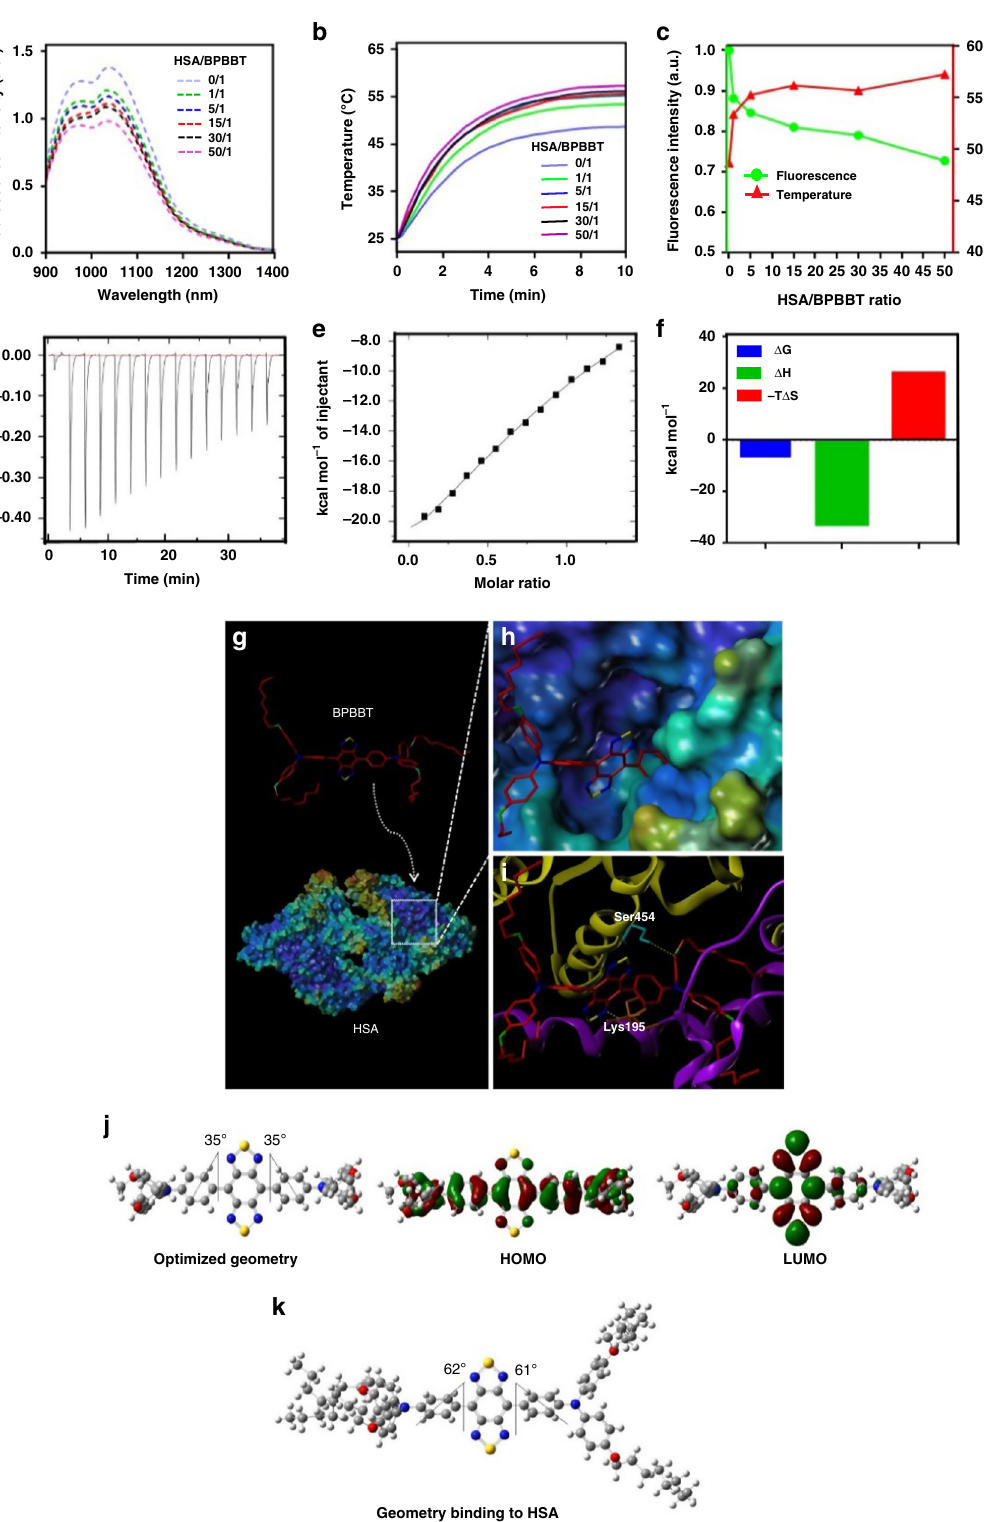
nanoparticle concentration and the laser power density. BPBBT NPs maintained 84 – 95% of fl uorescence intensity and 88 – 97% of the maximal NIR absorbance following the laser treatment with the power densities up to 20 W cm − 2 for 5 min, indicating that BPBBT NPs had a relatively good photostability (Fig. 5e, f, and Supplementary Fig. 5). The cellular uptake of BPBBT NPs by CT26-Luc mouse colon cancer cells was in